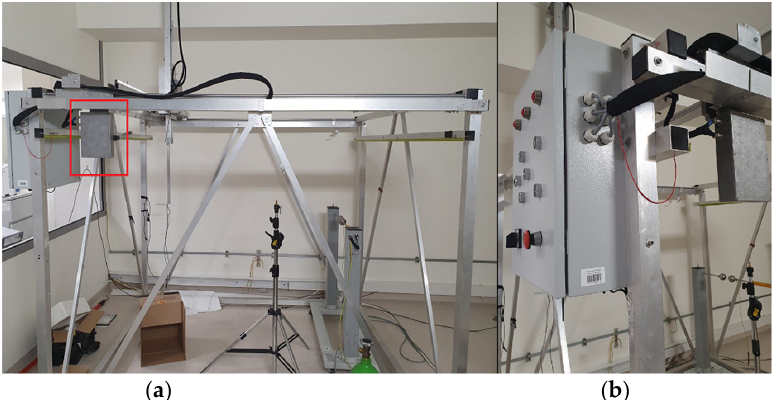
Figure 1. Measurement system: ( a ) construction (red marking—a box containing the data acquisition system and electronic components for powering the scintillation detector); ( b ) control panel.